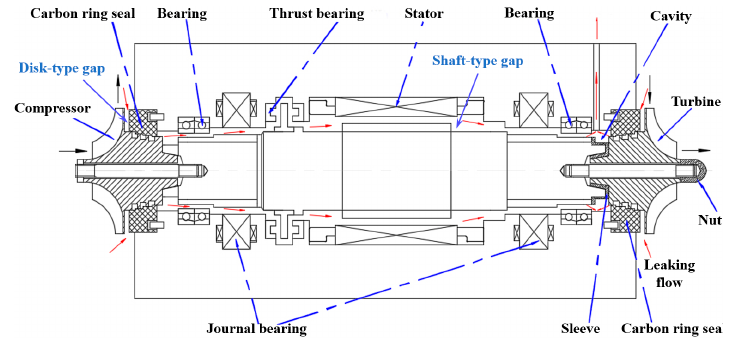
Figure 1. Meridian plane of a turbine-alternator-compressor (TAC) unit.